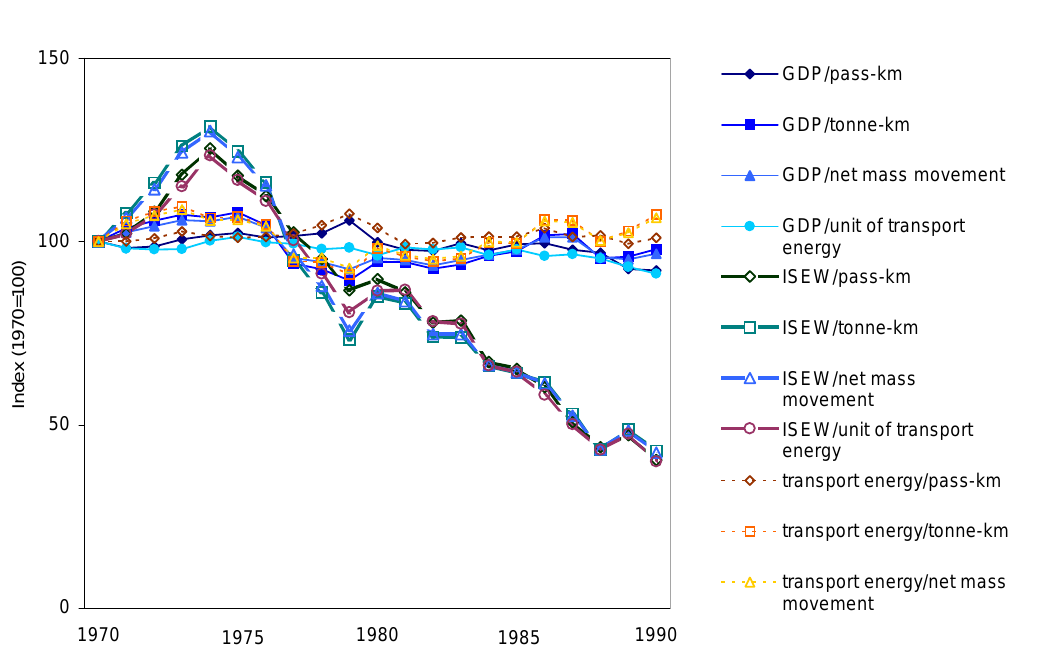
Figure 3. Transport intensity for the UK using ‘conventional’ and ‘alternative’ economic indicators,